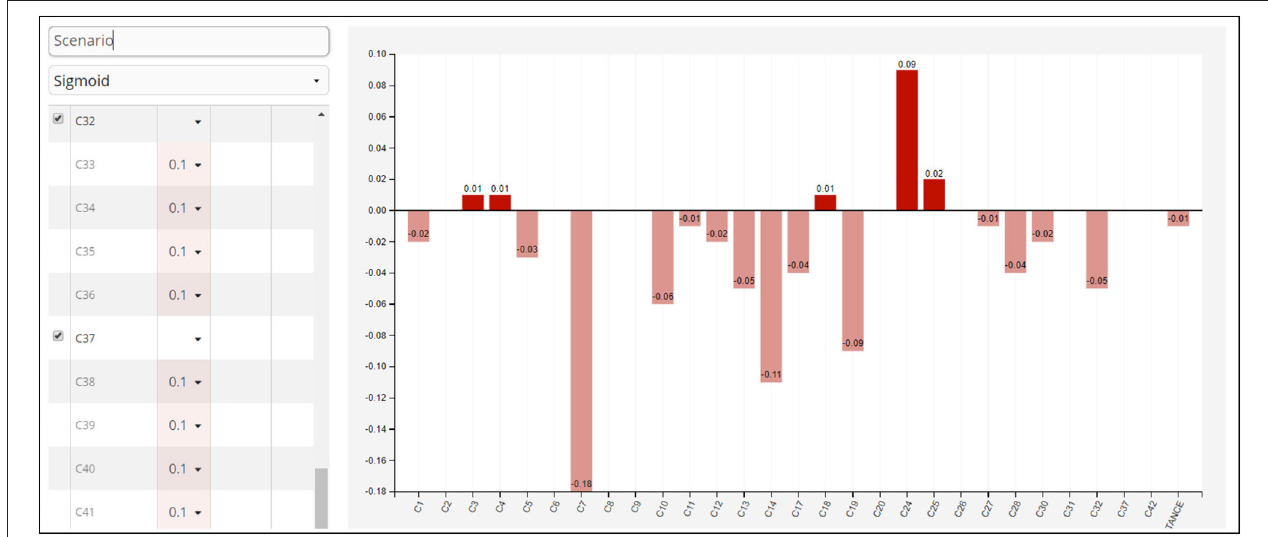
FIGURE 3 | The effect of the driver concepts in the full FCM for the worst case scenario compared to the steady